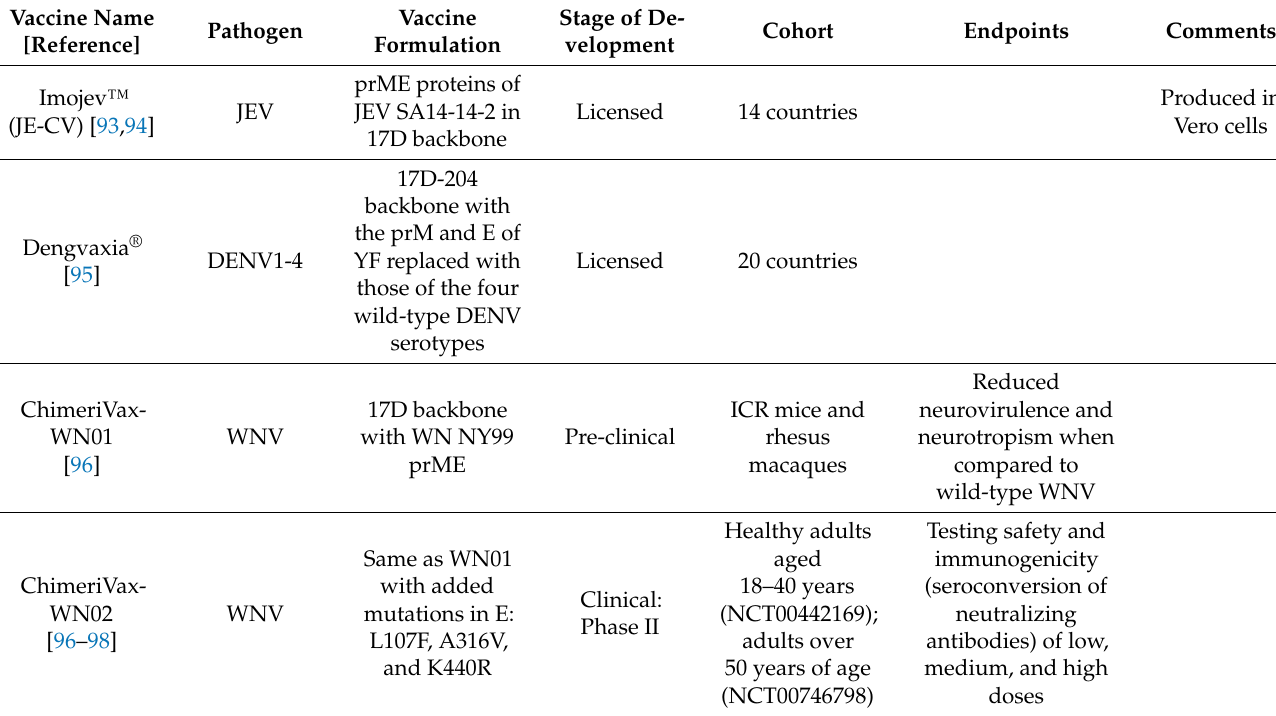
Table 3. Vaccine candidates in development that utilize yellow fever vaccine